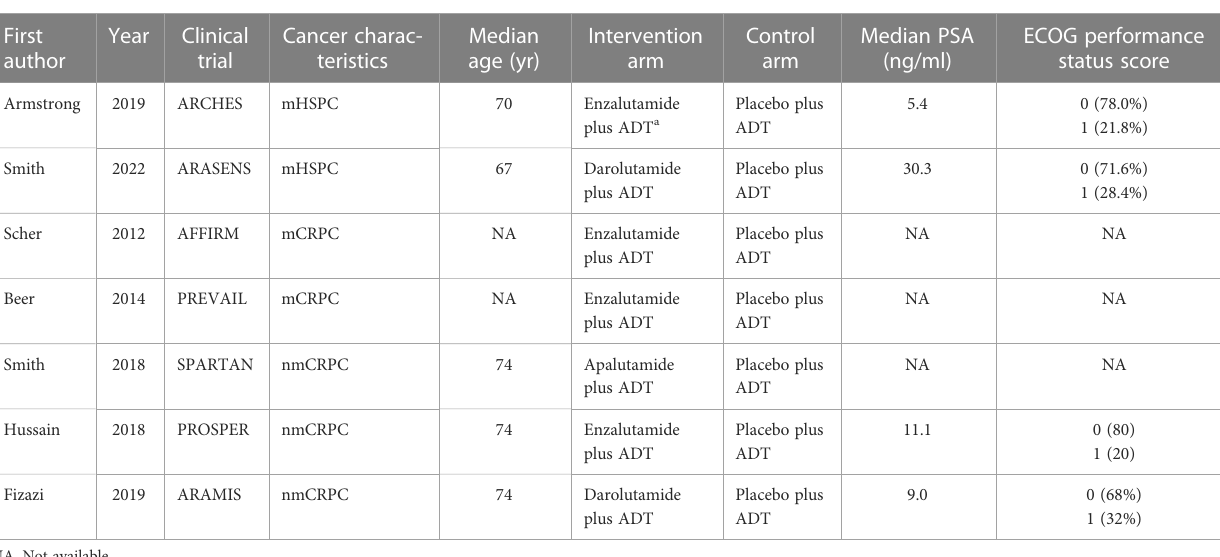
TABLE 1 Characteristics of the trails included in the meta-analysis.